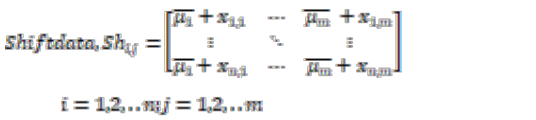
Table 2. List of kernel